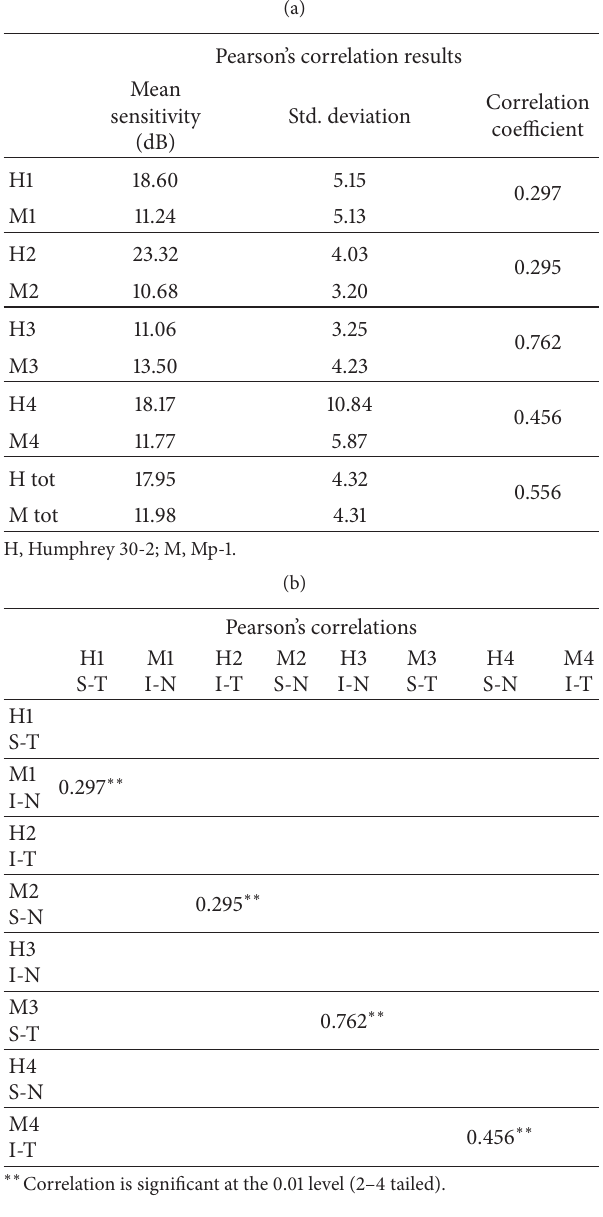
Table 2: (a) Mean sensitivity (dB) and standard deviation (SD) for each quadrant; (b) Pearson’s correlation between corresponding quadrants evaluated by Humphrey perimetry and